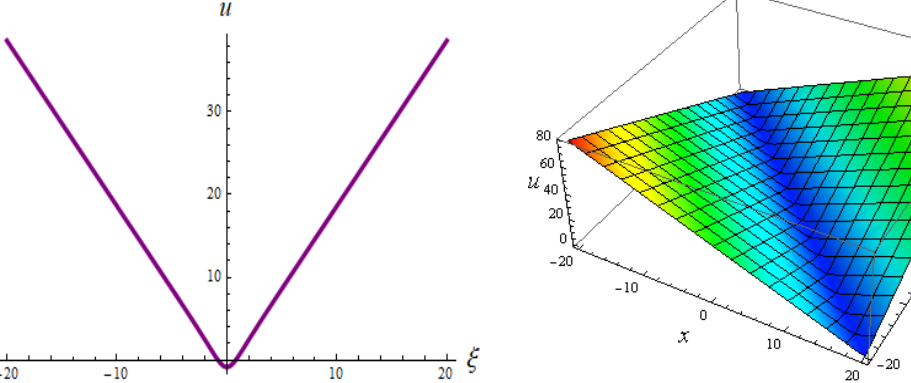
Figure 4: (a) 2D plot for u 6 . (b) 3D plot for u 6 ( x , y ) , when t = 0 .